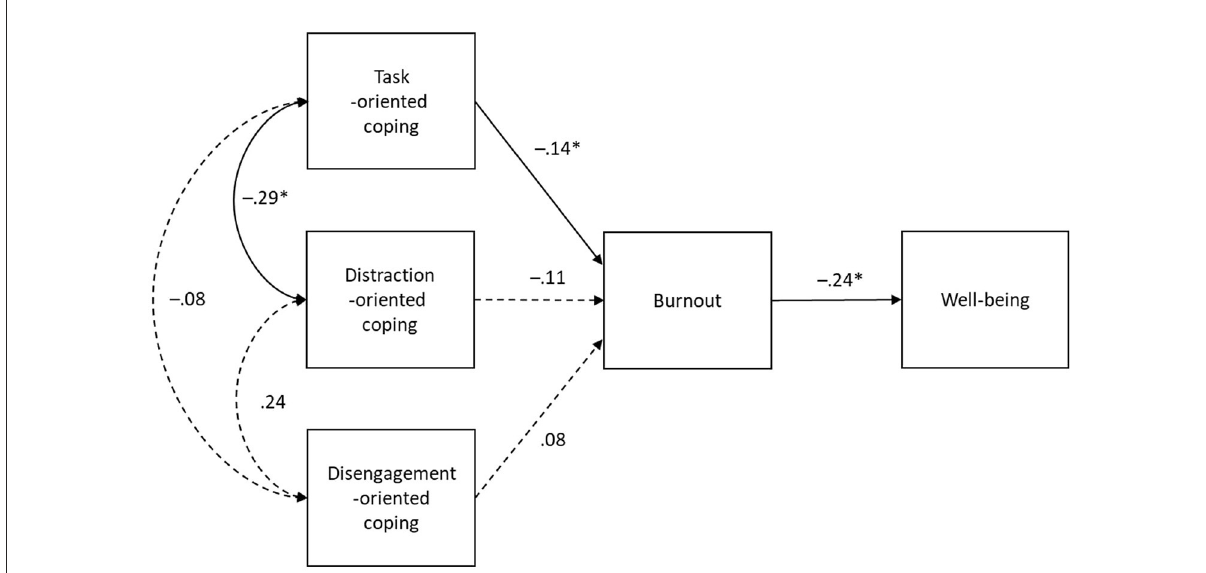
FIGURE1 Within-person model illustrating relationships between changes in coping strategies, athlete burnout, and well-being. * p < 0.05. Dashed lines represent non-significant paths ( p >